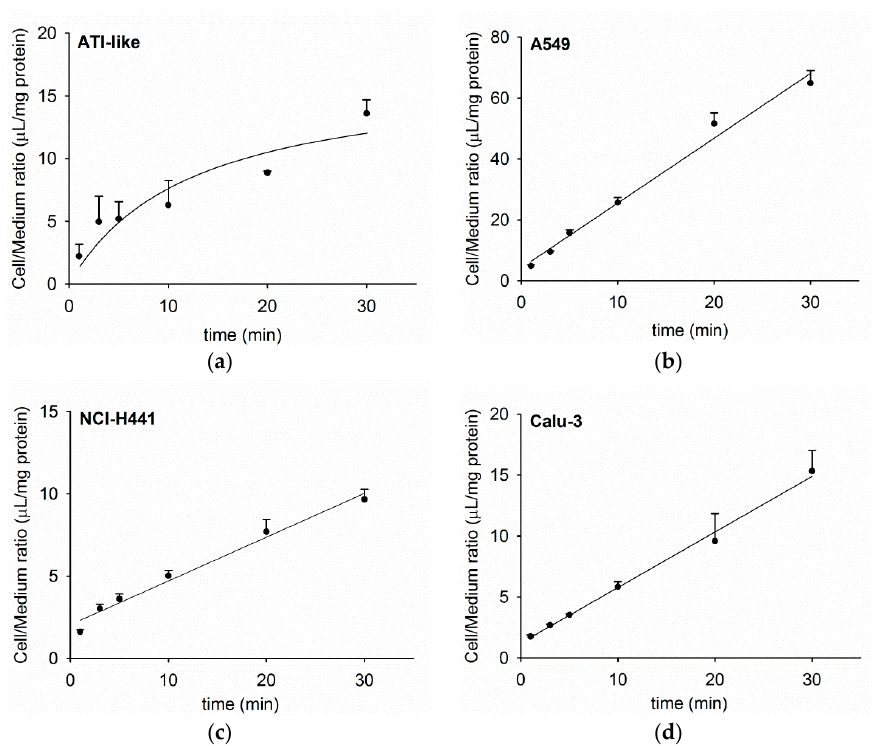
Figure 1. Time course of [ 3 H]-AC uptake into human alveolar ( a ) alveolar type I (ATI)-like, ( b ) A549, ( c ) bronchiolar (NCl-H441), and ( d ) bronchial (Calu-3) epithelial cell types. Cell uptake of [ 3 H]-AC was performed at 37 °C for 30 min and data were fitted by means of non-linear regression analysis. Each point represents mean ± SD ( n = 3).